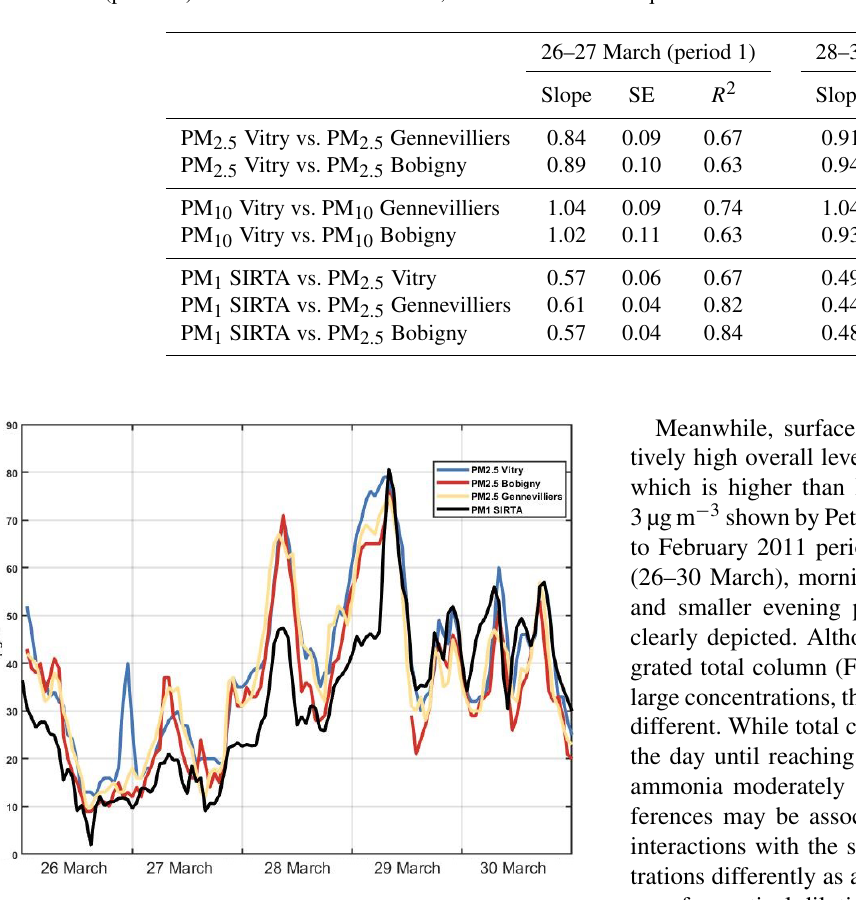
Figure 4. Particle matter concentrations measured at the surface at the stations of Vitry, Bobigny, Gennevilliers and SIRTA, respec- tively, southeast, northeast, northwest and southwest of Paris. Parti- cle concentrations in terms of PM 2 . 5 and PM 1 are provided, respec- tively, at the three Airparif stations and at the last one in the period between 26–31 March